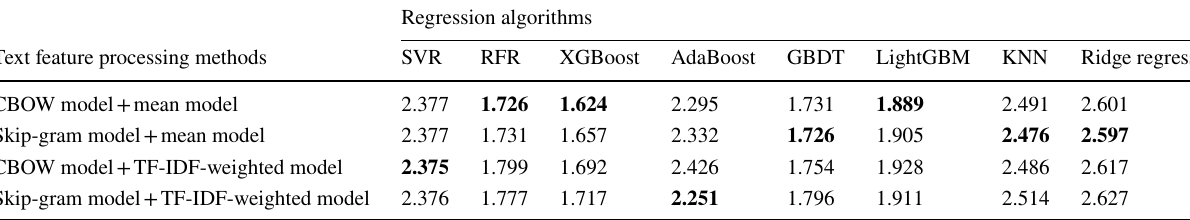
The bold indicates the best text feature processing method corresponding to the